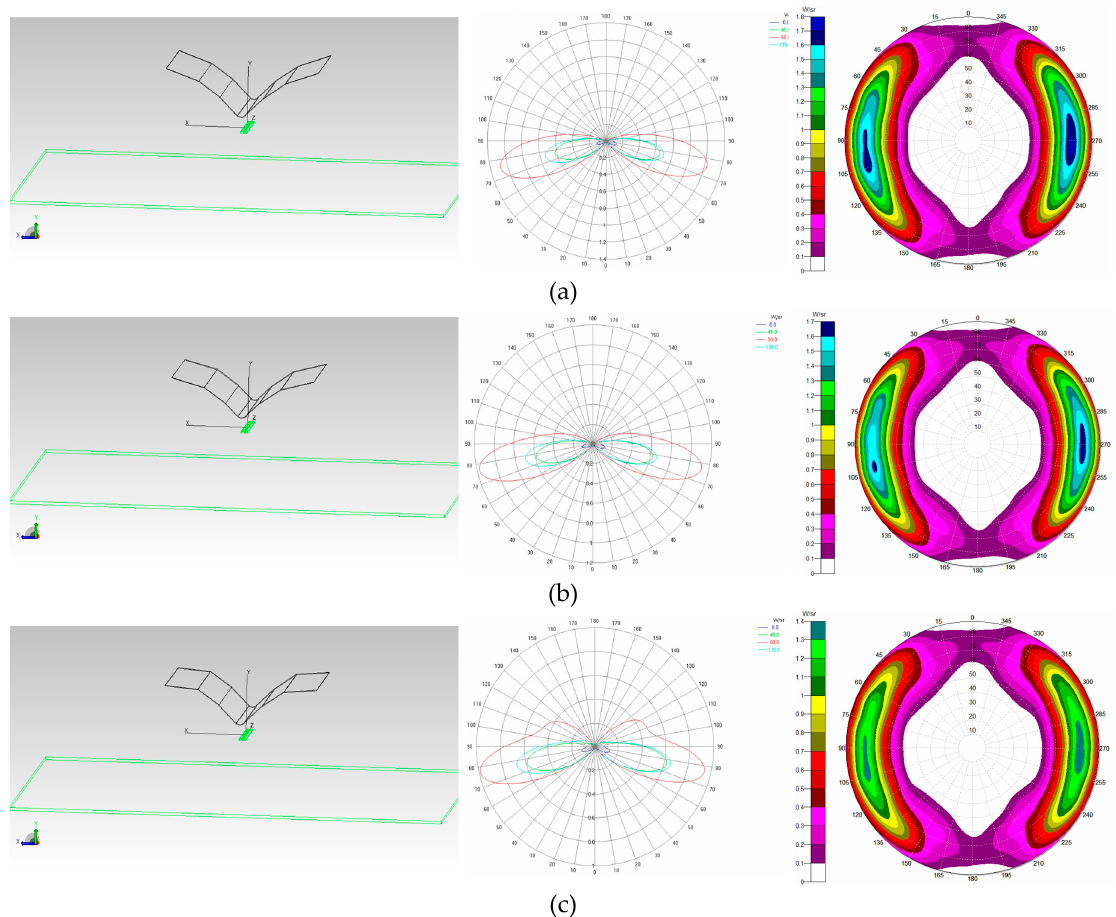
Figure 7. ( a ) Light distribution curves of the optimized type A reflector targeted at a 170 peak emitting angle; ( b ) Light distribution curves of the optimized type B reflector targeted at a 170 peak emitting angle; ( c ) Light distribution curves of the optimized type C reflector targeted at a 170 peak emitting angle.